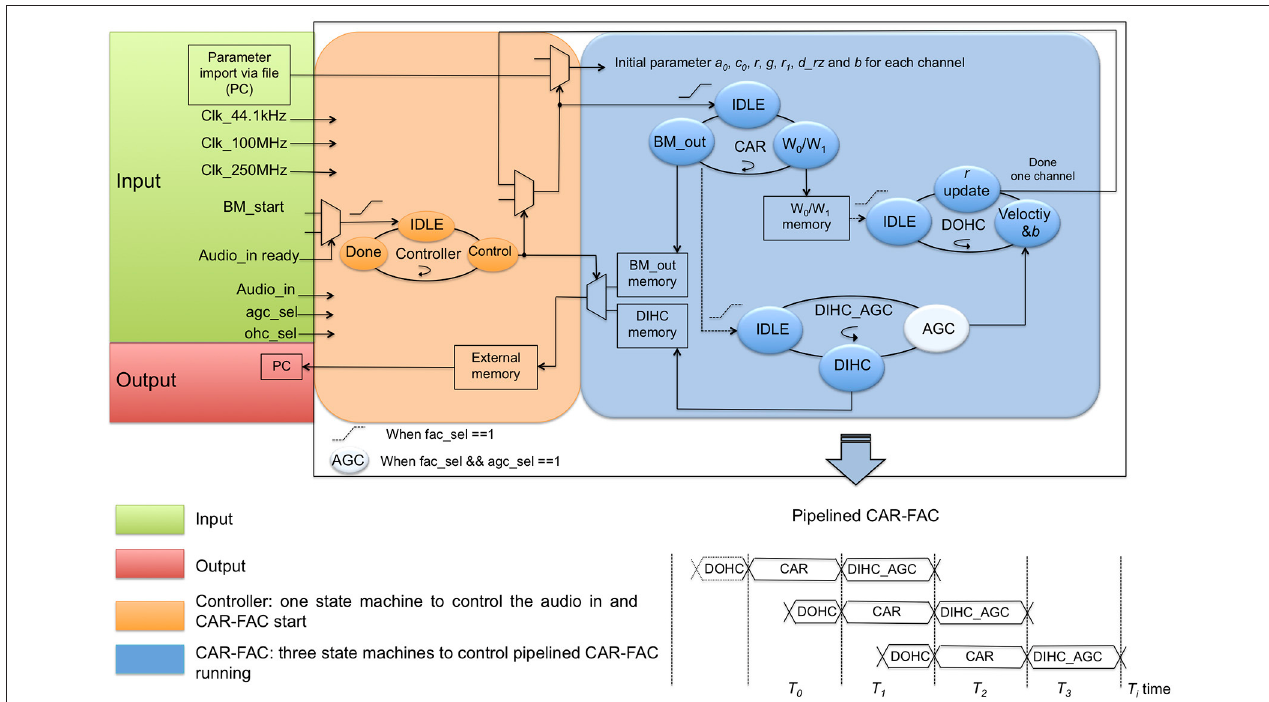
FIGURE 8 | CAR-FAC system design diagram. The CAR-FAC system is implemented with 20-bit word length for the design coefficients, BM output, and DOHC output, and 14-bit for the DIHC output and the AGC output. The controller state machine determines the cochlear channel to be processed at any particular time and controls the CAR-FAC coefficients and data for that channel. The BM_start signal controls the start of the system through the controller, and it is triggered by the Audio_in_ready signal. The ohc_sel is a selector switch for the CAR/CAR-FAC function. The agc_sel is a switch for the AGC loop function. The CAR state machine calculates the transfer function of Equation (1) and controls the DOHC and DIHC_AGC start in the system. The DOHC state machine calculates Equation (10–12) and feeds back an updated r to the CAR. The DIHC-AGC calculates Equation (13–17), as well as the AGC_loop function shown in Figure 6 . The AGC output b feeds back to the DOHC module via Equation (10). The pipelined CAR-FAC timing diagram is shown in lower right.